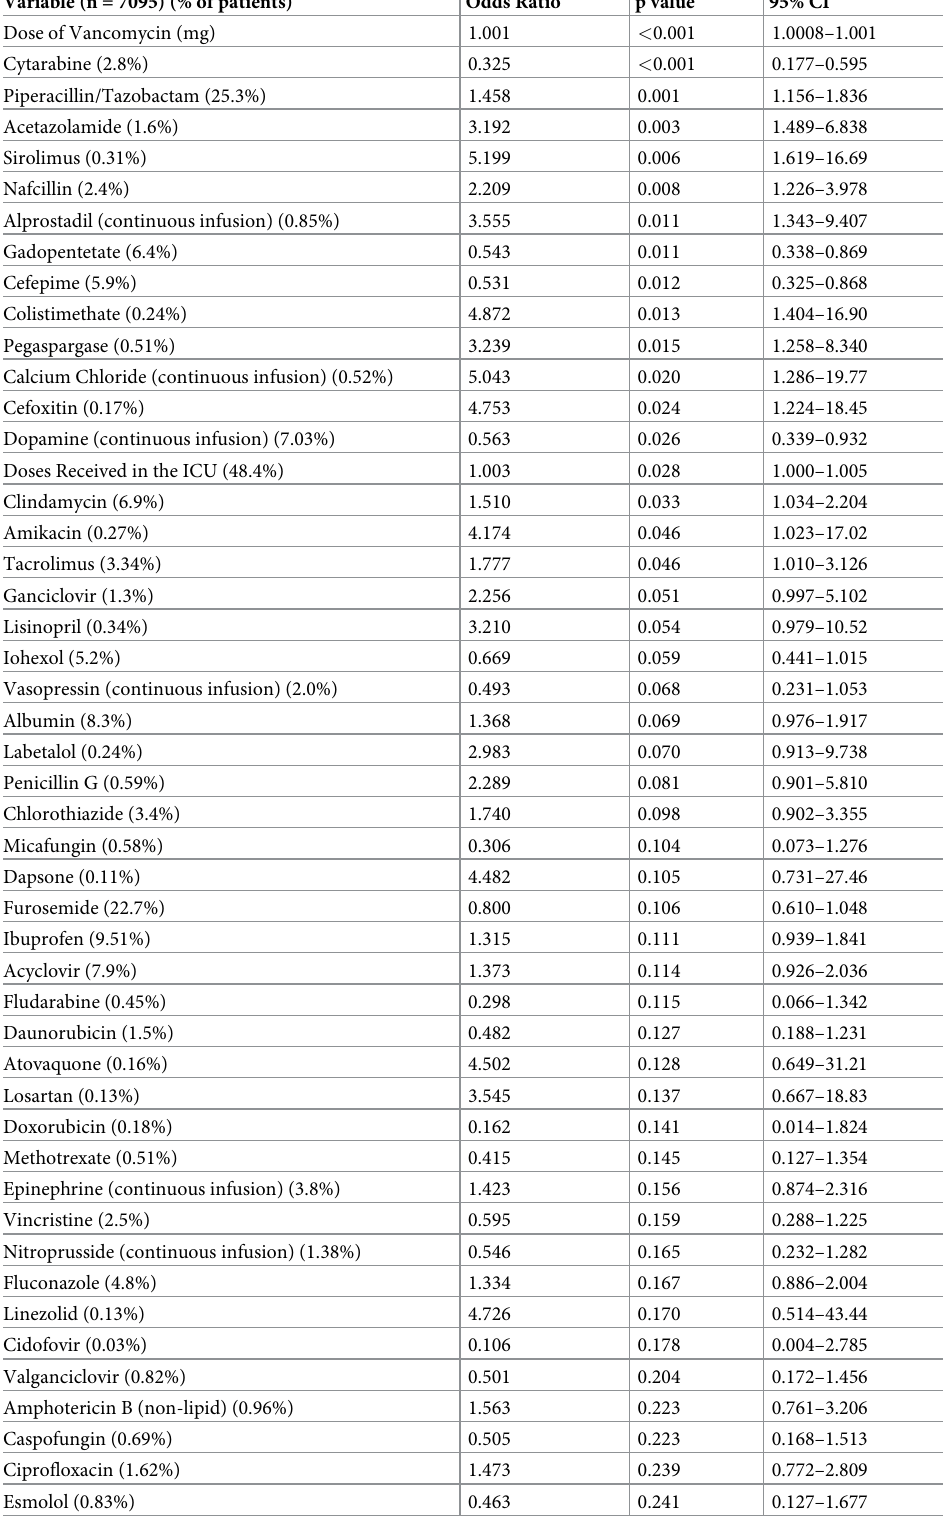
Table 4. Ordinal logistic regression model for vancomycin associated acute kidney